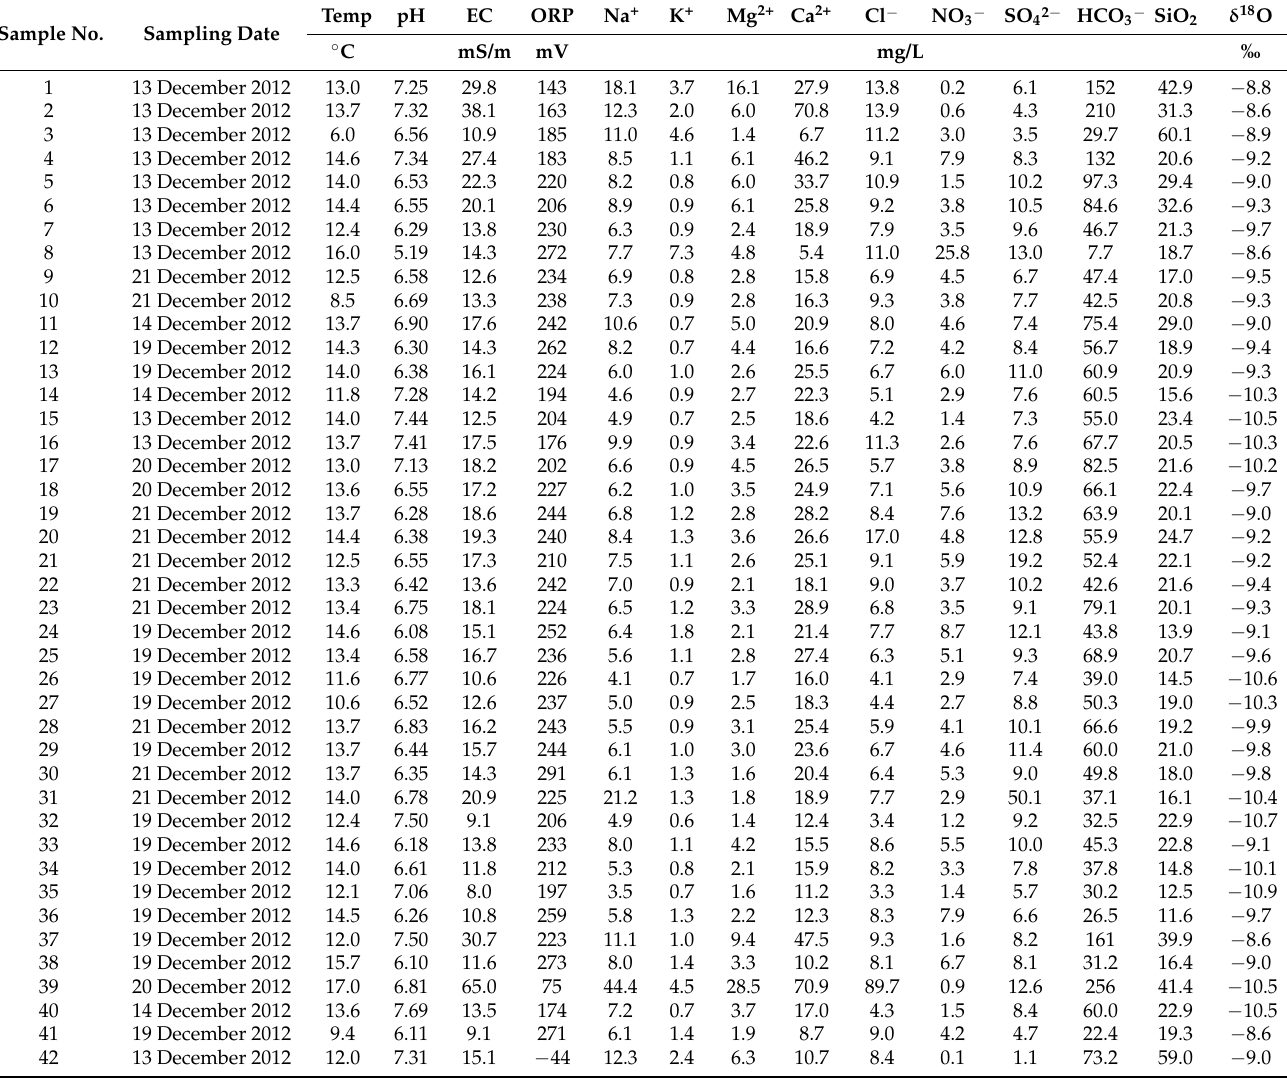
Table 10. Water temperature, pH, electric conductivity (EC), oxidation–reduction potential (ORP), chemical, and δ 18 O composition for groundwater samples in the Sho River alluvial fan on 13 December to 21 December 2012. Sample No.